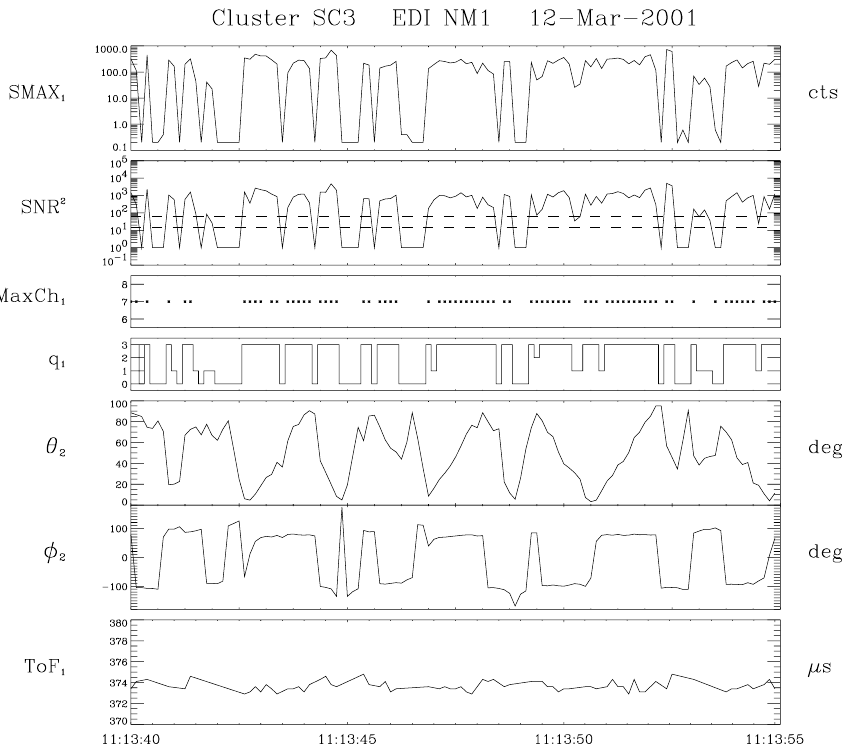
Fig. 3. EDI raw-data from Gun2 and Detector1 on SC3 for a 15-second period on 12 March 2001, when the magnetic field strength was 100nT. The top panel shows SMAX 1 , the maximum counts recorded (in 2 ms) in any of the 15 correlators in the Detector; the next panel shows the square of the signal-to-noise ratio, SNR 2 , computed from the counts in the matched and unmatched correlators; the horizontal dashed lines in this panel indicate the thresholds for SNR 2 used by the on-board software to identify the beam (angle-track); the third panel shows MaxCh 1 , the correlator channel that received the maximum counts; when MaxCh 1 = 7, time-track has been achieved; q 1 (fourth panel) is a quality-status indicator explained in the text; the next two panels show 2 2 and 8 2 , the elevation and azimuth angles of the Gun 2 firing directions; ToF 1 (last panel) is the time-of-flight of the electrons from Gun2 to